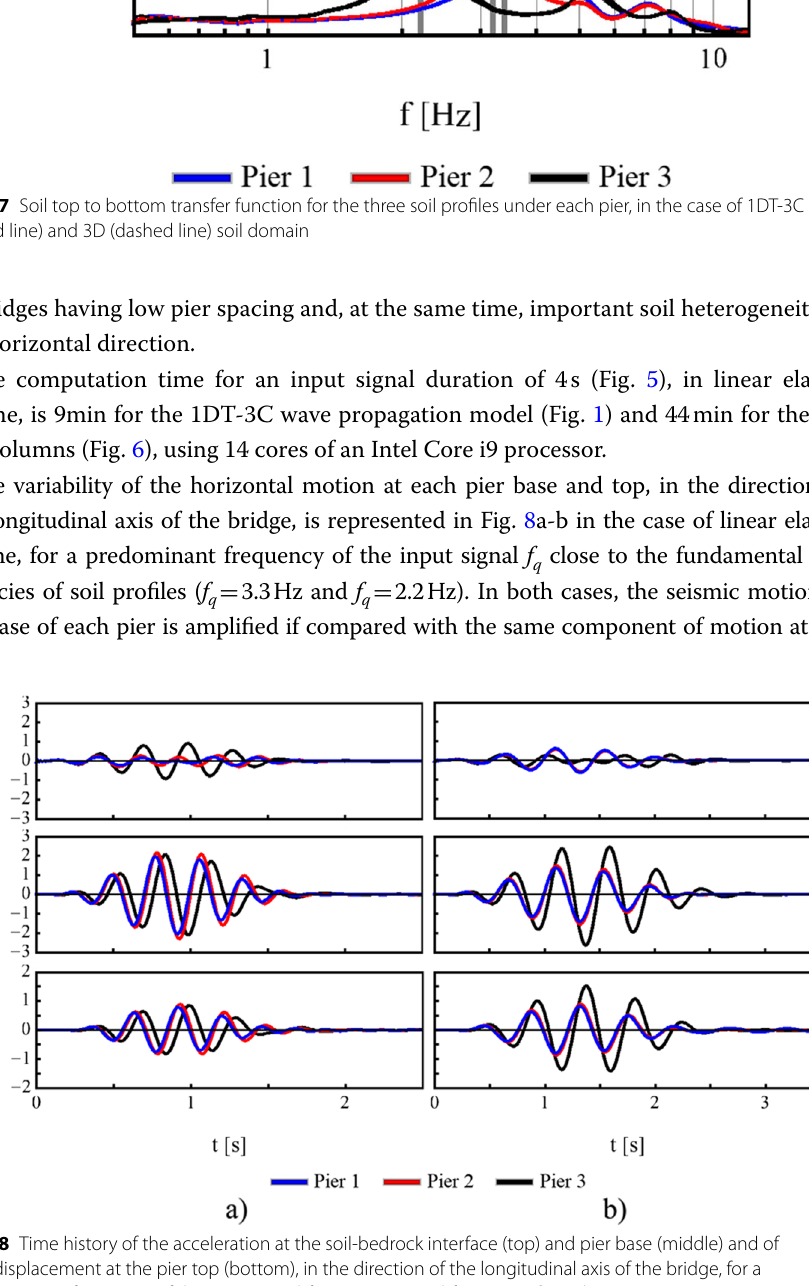
3.3 Hz ( a ) and f q 2.2 Hz ( b ), in linear = =